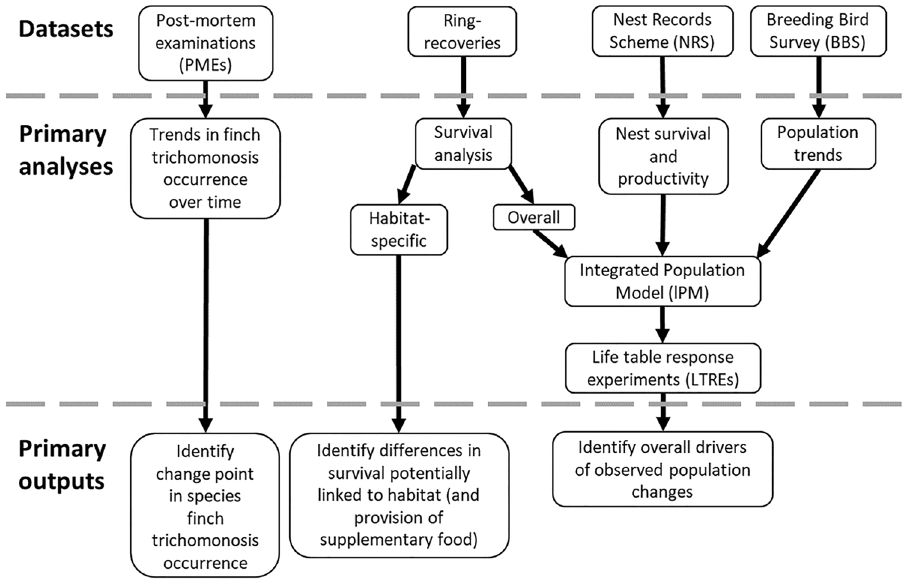
Figure 2. Schematic overview of the datasets and analyses utilised in this research, and their primary